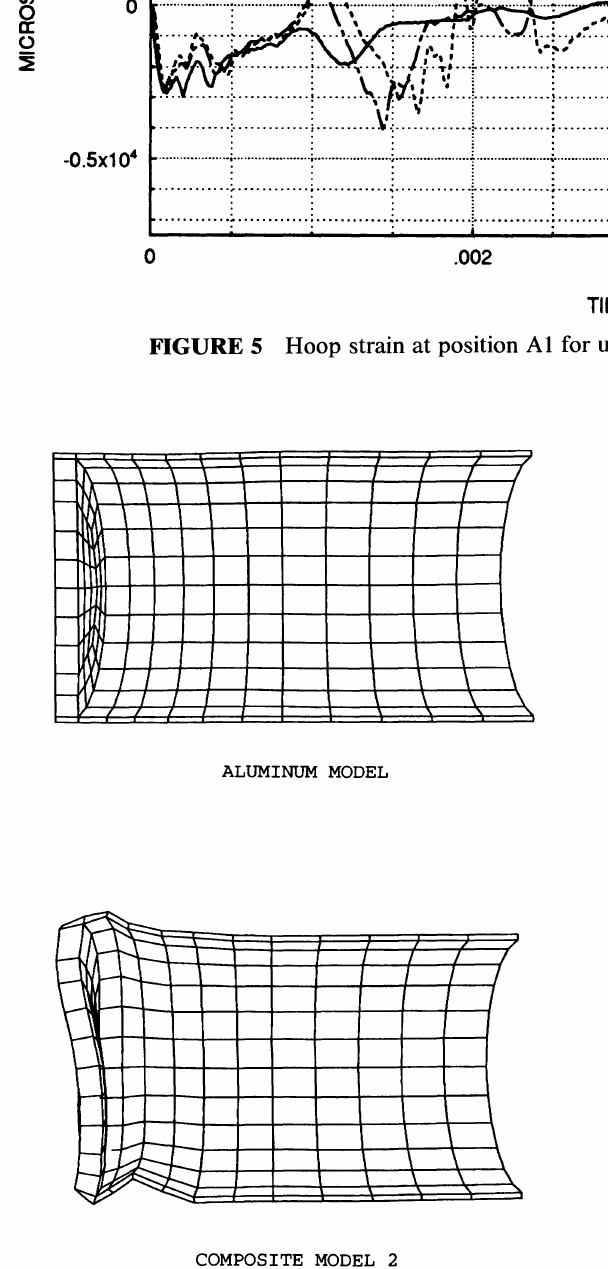
FIGURE 6 Deformation of uncoated and coated cyl inders at 5.86